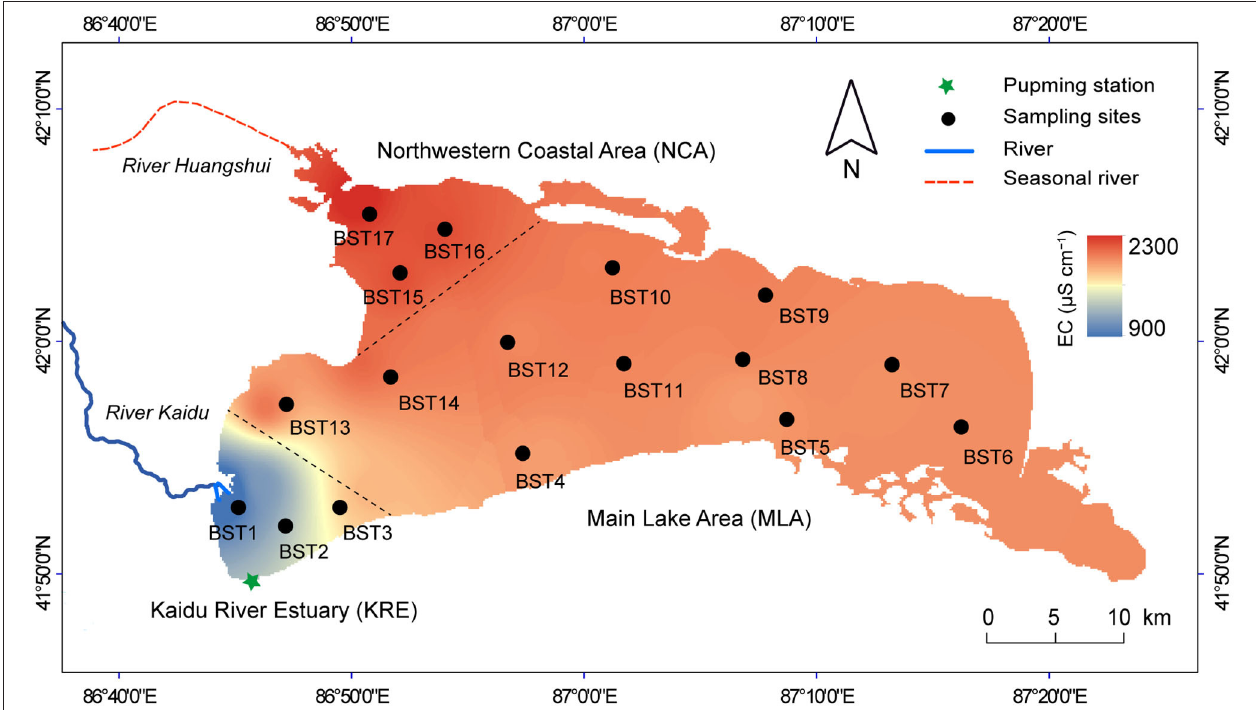
FIGURE 1 | Map of Lake Bosten, showing study area, sampling sites and electrical conductivity (EC) in water column. Electrical conductivity was the average value from 2010 to 2019, which derived from the long-term monitoring of the institute of Lake Bosten. The lake area was divided into three subregions according to the EC gradient: Kaidu River Estuary (KRE), Main Lake Area (MLA) and Northwestern Coastal Area (NCA).